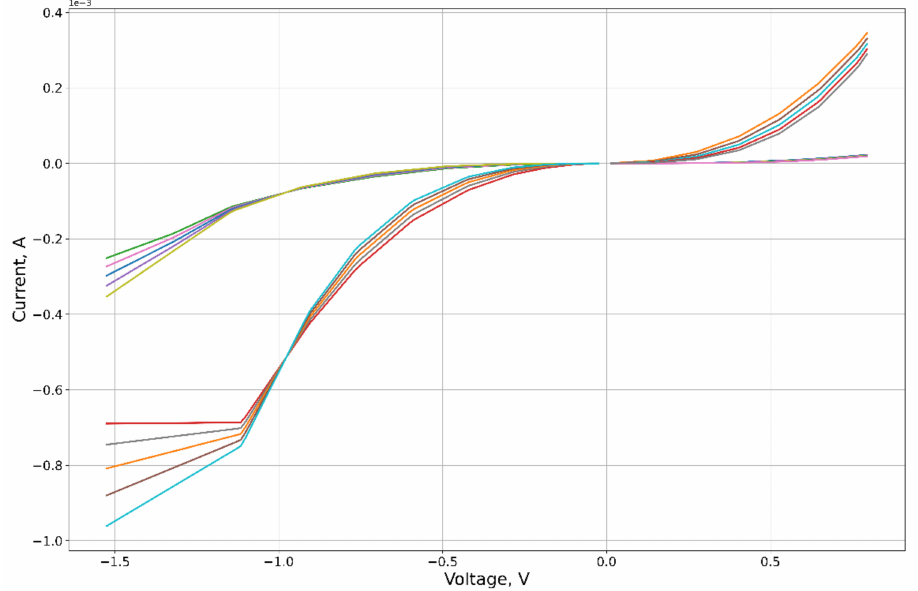
Figure 9. Example of curvature change of first synthetic curve. Table 2. Variation of the error function from a curvature change at each point in steps of